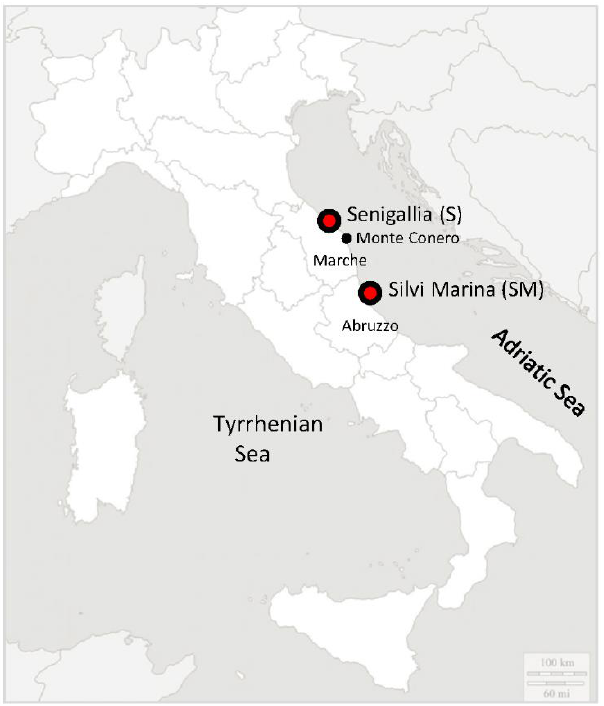
Figure 1. Geographical localization of sampling sites considered in the present work.